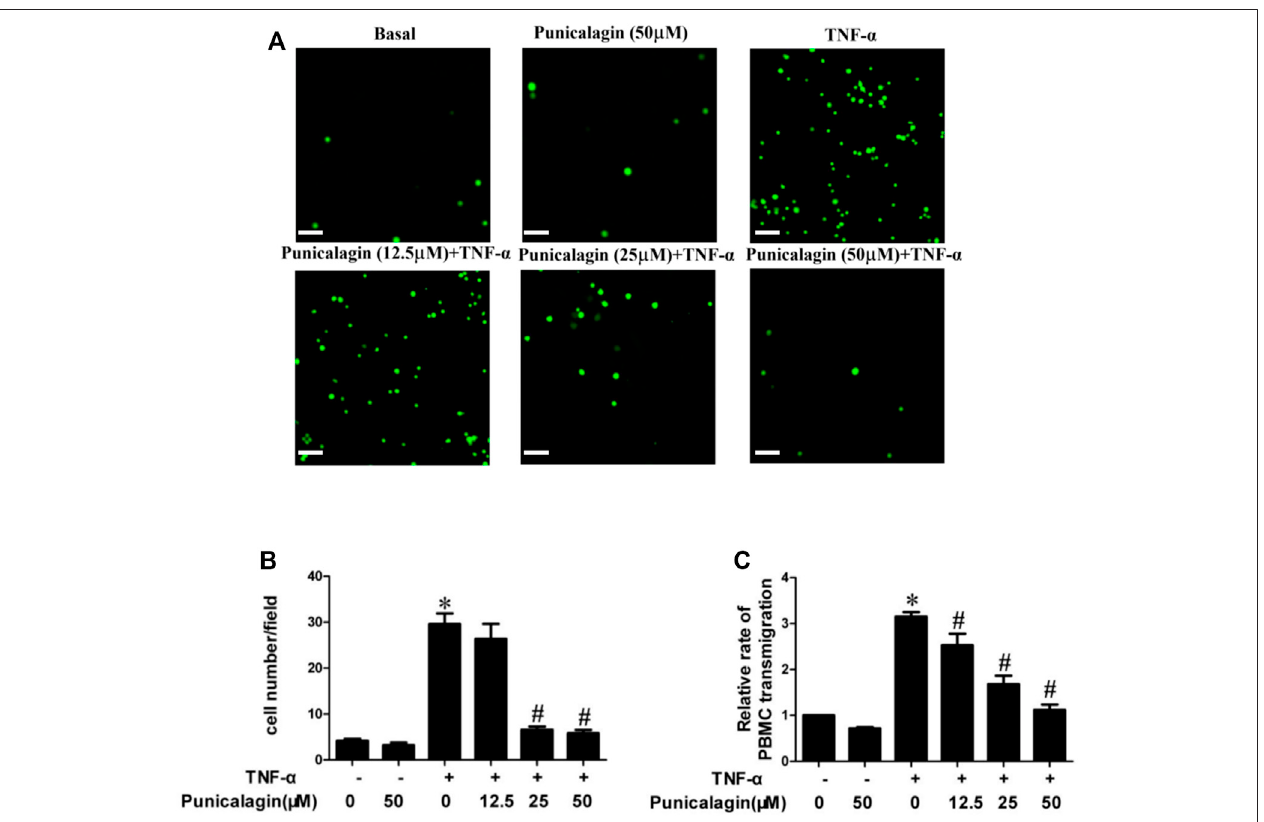
FIGURE 3 | Inhibition of punicalagin on adhesion of PBMC to ECs in in fl ammation. (A, B) Figure A shows the adhesion of PBMC observed in different culture conditionsunderaninverted fl uorescence microscope. (B) Thequantity ofadherentcells. (C) ResultsofTranswellmigrationassaytoexploretheeffectofpunicalaginon TNF- α -induced leukocyte migration across the endothelium. * p < 0.05 vs HUVECs without TNF- α , # p < 0.05 vs treatment with TNF- α